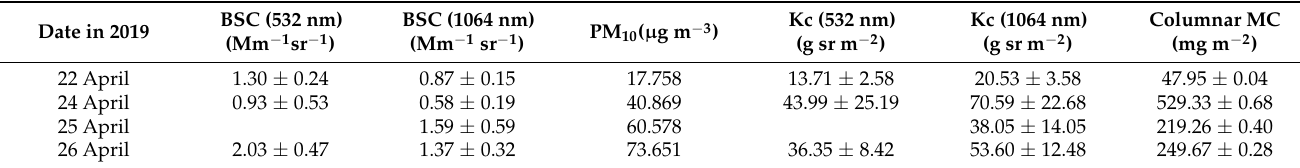
Table 1. Calibration data for converting aerosol backscatter to mass-concentration.